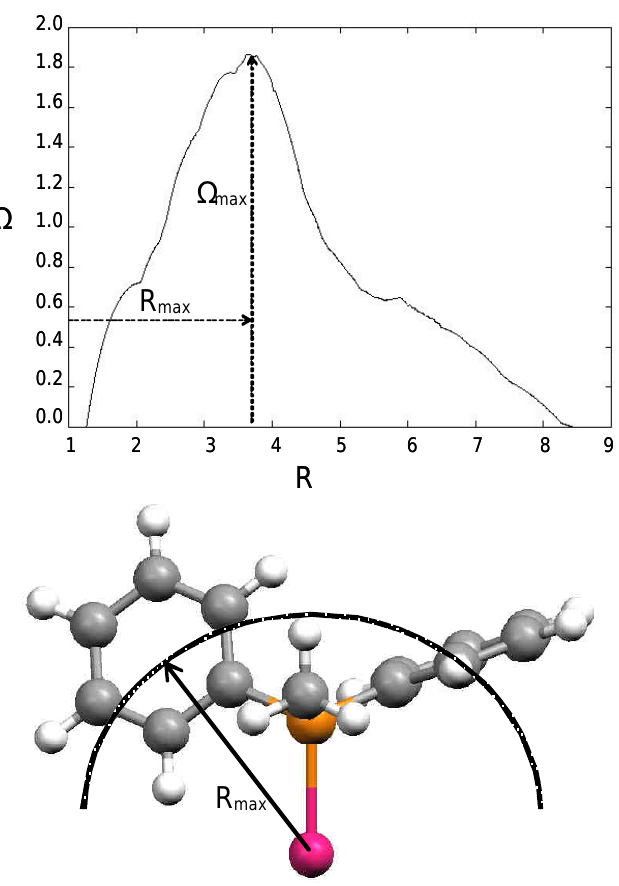
Figure 1 . Some steric descriptors calculated with the Steric® program. (top) Steric profile for the monophosphine PPh Me ligand. R is the radius of the growing sphere centered on the metal atom. R 2 is the distance between the Pd atom and the bulkiest cross-section of the ligand, Ω at this cross-section. (bottom) 3D representation of the ligand steric parameter R